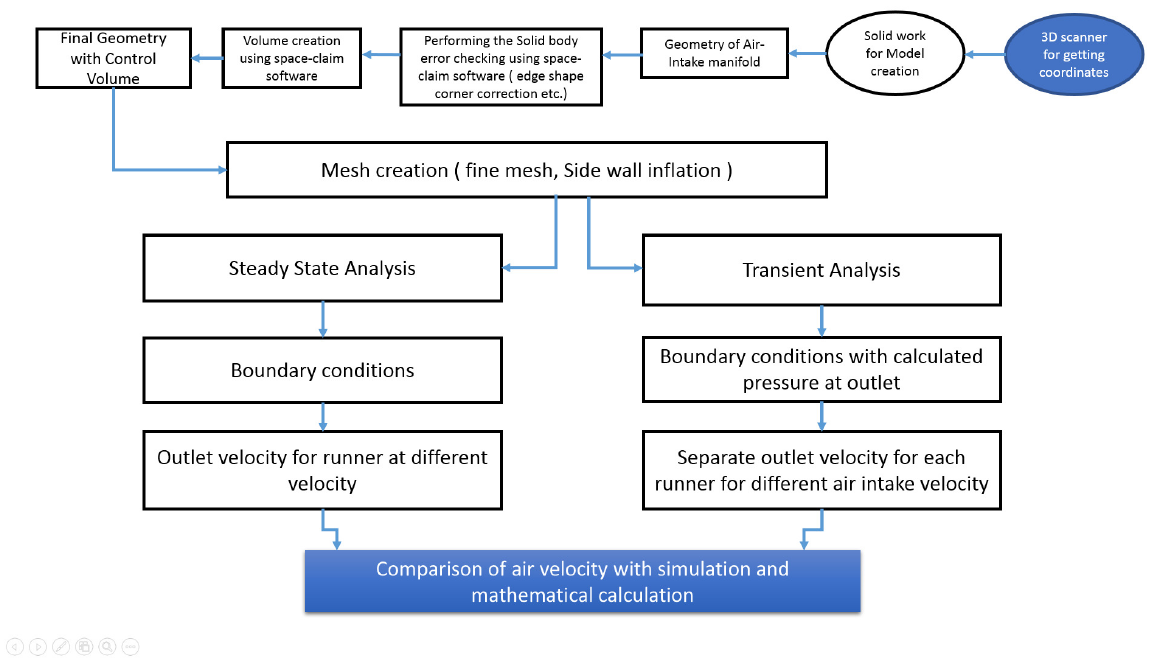
Fig. 2. Ansys Simulation Procedure